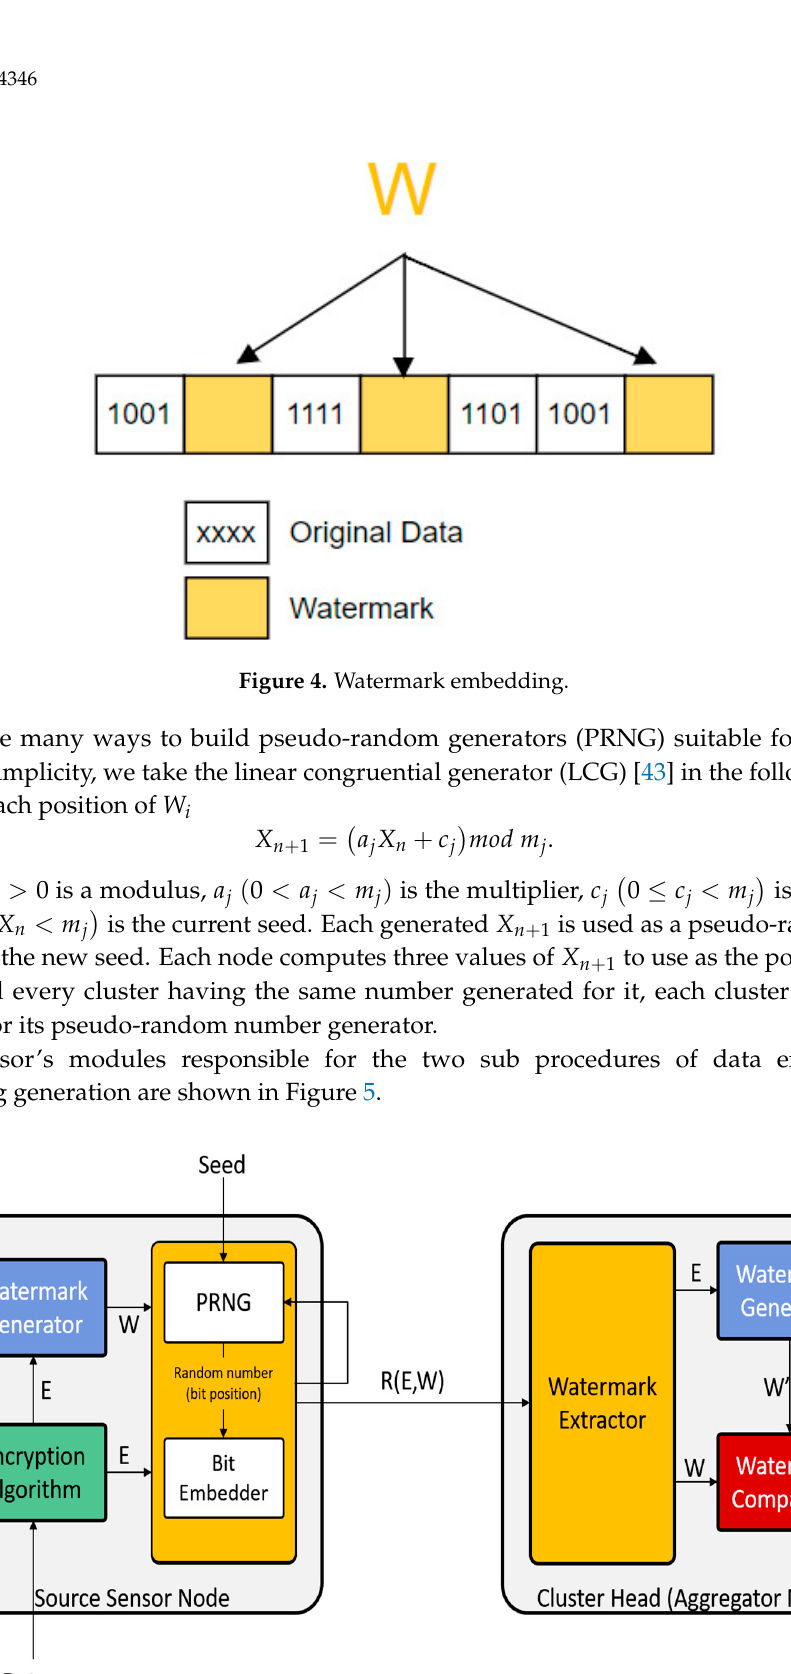
Figure 5. A block diagram of the Randomized Watermarking Filtering Scheme (RWFS) showing the modules of the sensor node and cluster head. It also shows the flow of data between the modules.